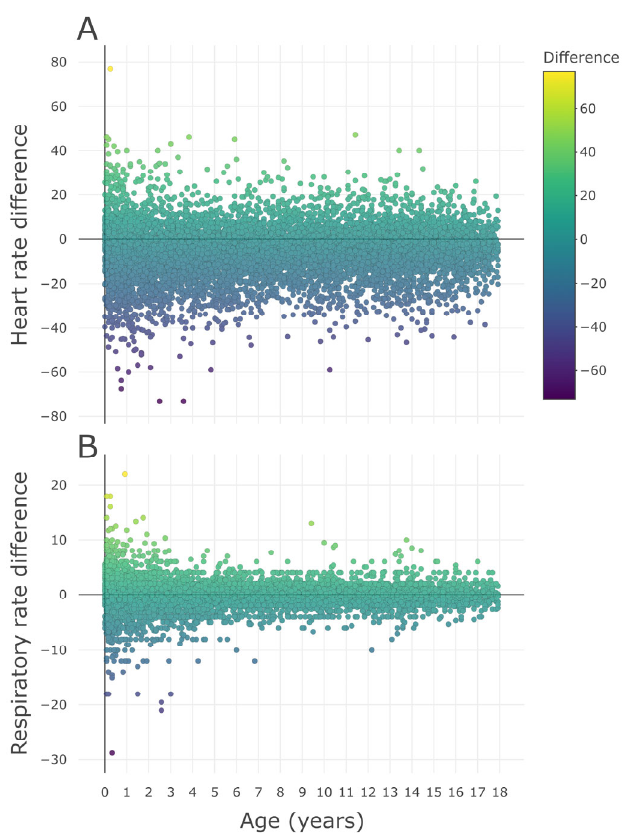
Figure 1. Differences in measurements by age. ( A ) HR difference and ( B ) RR difference by age. The difference of each measurement was defined as the nighttime measurement minus the daytime measurement. Daytime was defined as 8:00 to 20:00, and nighttime was defined as 20:00 to 8:00 the next day. HR = heart rate, RR = respiratory rate.